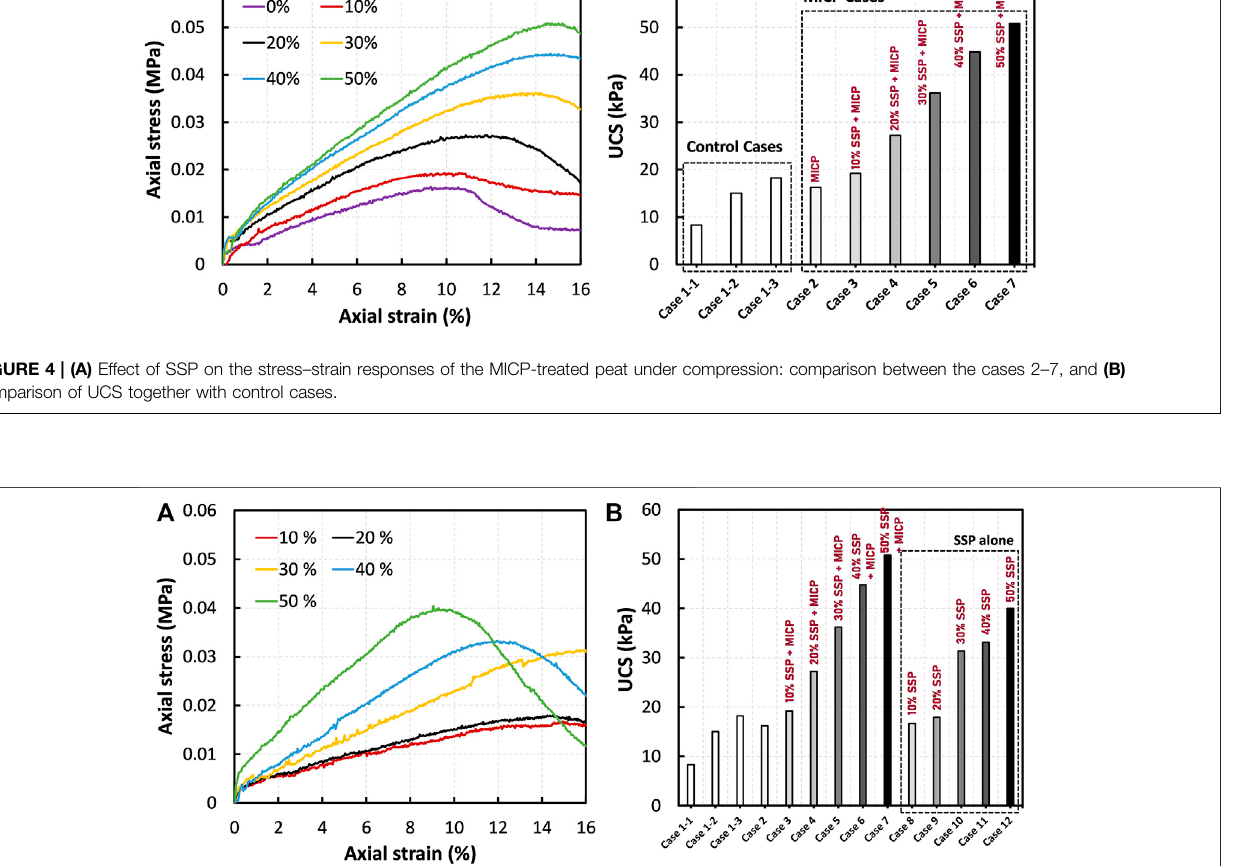
Frontiers in Environmental Science |